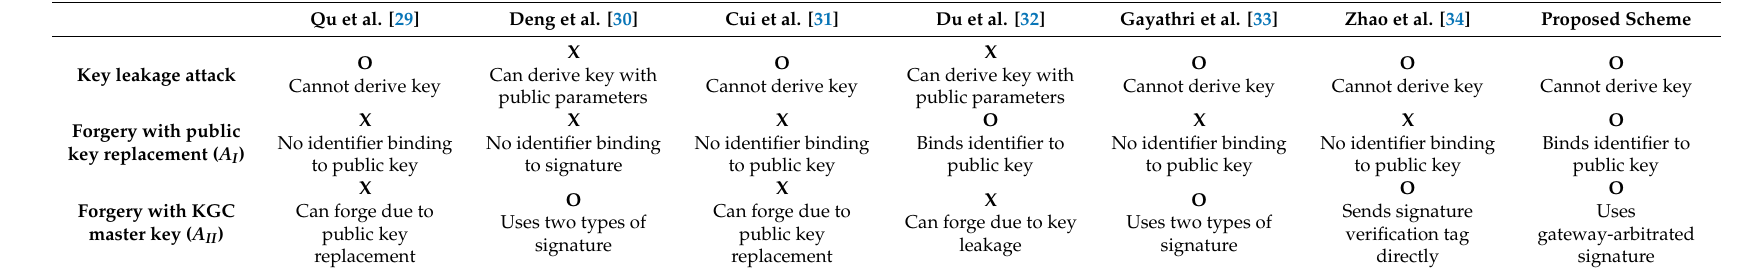
Table 1. Security analysis of various certificateless aggregate signature schemes, including the proposed